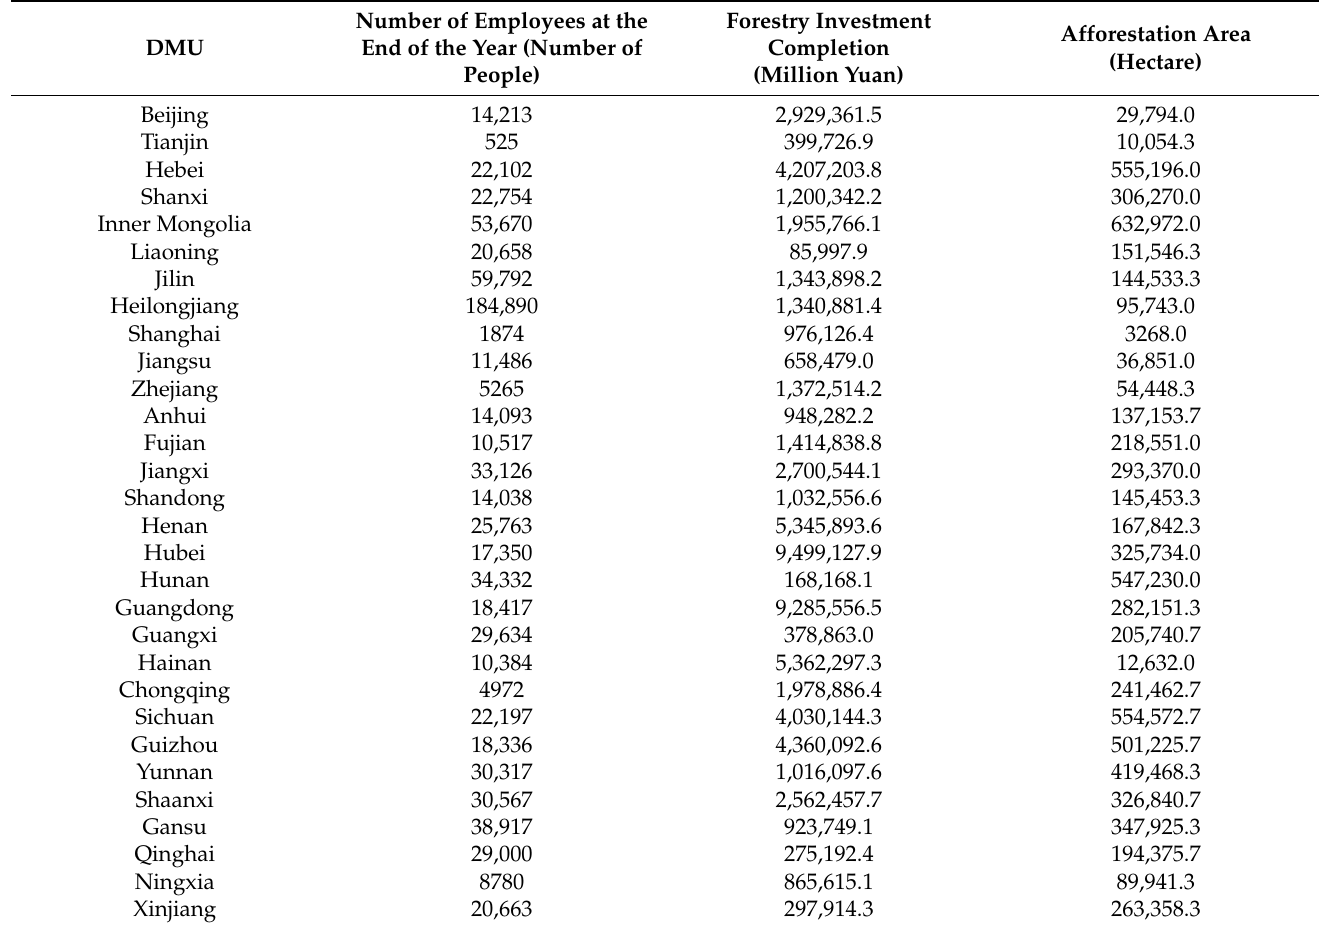
Table 3. Estimated input indicators by region in